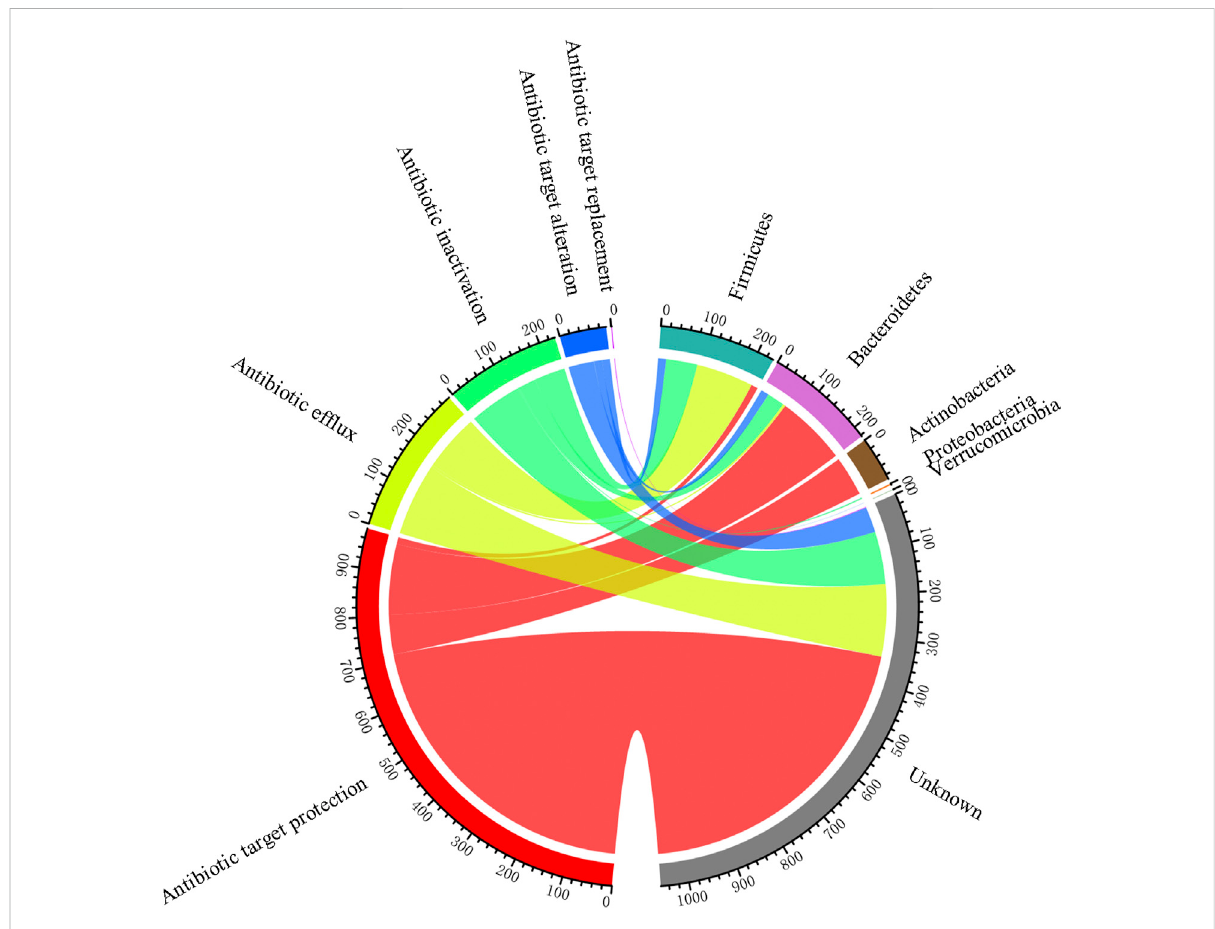
FIGURE 8 ARG pro fi les based on their hosts and resistance